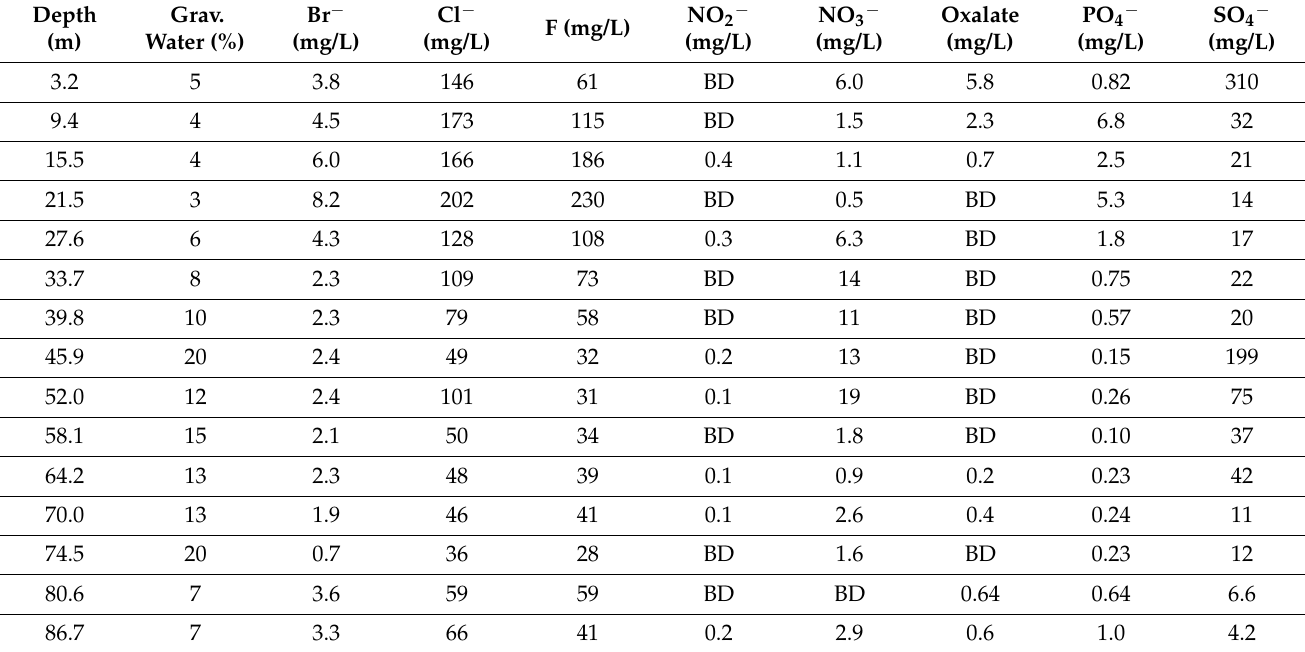
Table 3. Borehole 7 pore water anion concentrations.